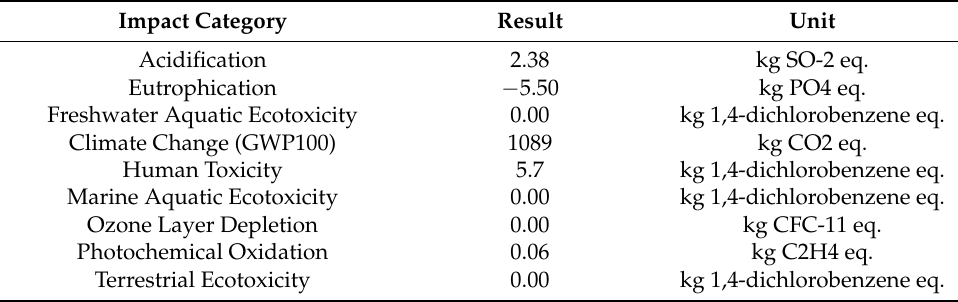
Table 7. Life cycle impact assessment data, using CML baseline.